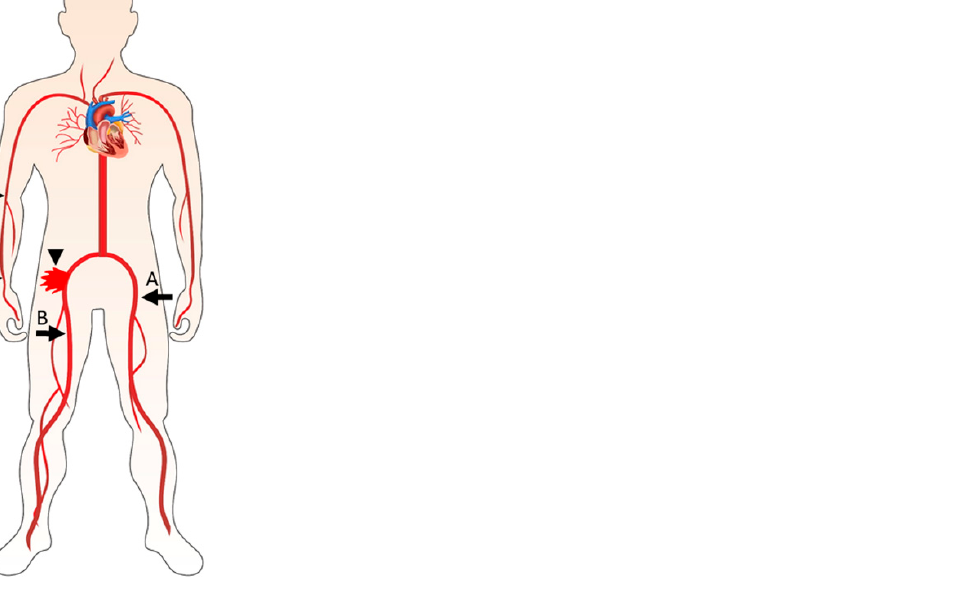
Figure 1. Secondary vascular access sites. Secondary vascular access sites which may be used as ports of entry for a safety wire and delivery of devices for percutaneous repair of femoral artery injury (arrowhead): ( A ) contralateral femoral artery, ( B ) ipsilateral distal femoral artery, ( C ) bra- chial artery, ( D ) radial artery. artery, ( D ) radial